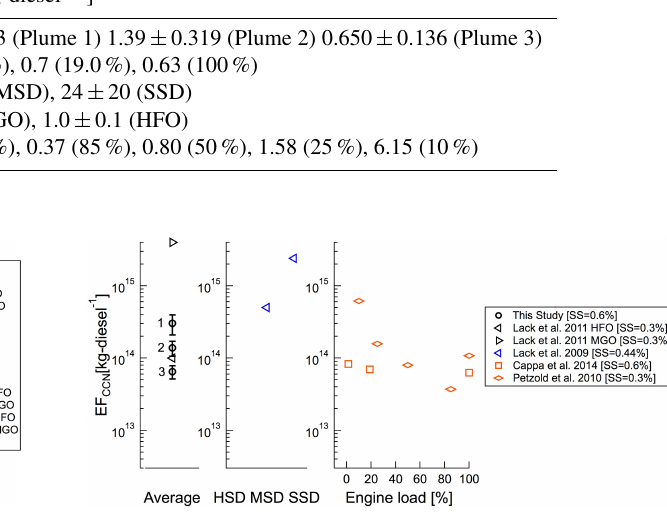
Figure 14. Emission factors for black carbon; fuel type (HFO: heavy fuel oil with high sulfur content, and MGO: marine gas oil with low sulfur content), or vessel class based on gross metric ton- nage (HSD: high speed diesel < 5000t, MSD: medium speed diesel 5000–30000t, or SSD: slow speed diesel > 50000t); plumes 1 and 2 are indicated on the plot with numbers 1 and 2 and the estimated uncertainty is shown by error bars (plume 3 emission factor is not shown because the instrument was malfunctioning during this ex- periment).